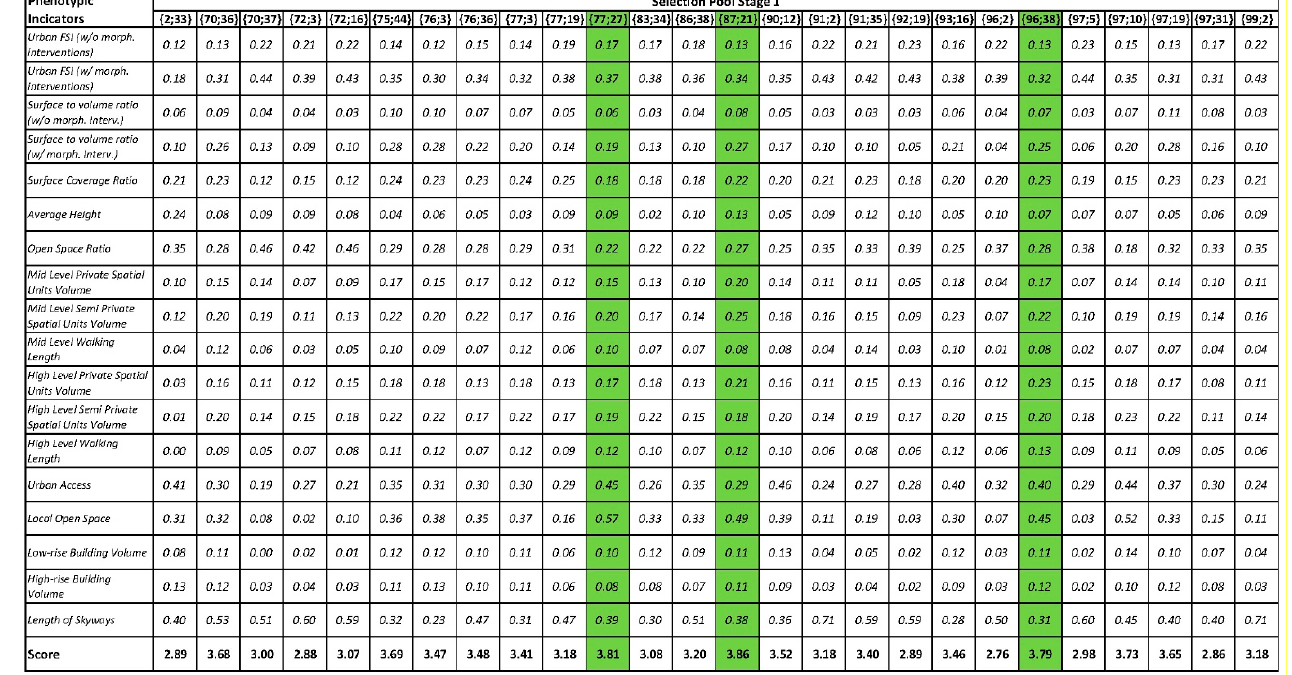
Figure 20. The results of each solution and its applied phenotypic indicator. The solutions above a specific threshold are highlighted as the top-performing solutions.